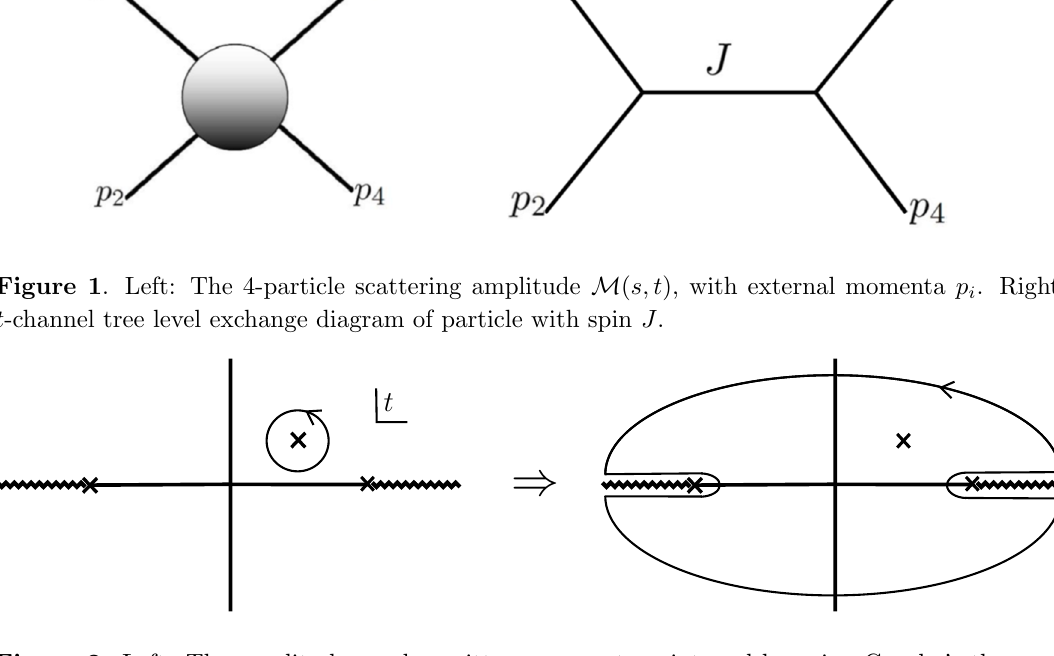
Figure 2 . Left: The amplitude can be written as a contour integral by using Cauchy’s theorem. Right: Upon deforming the contour, there will be contributions from the branch cuts and from the arcs at